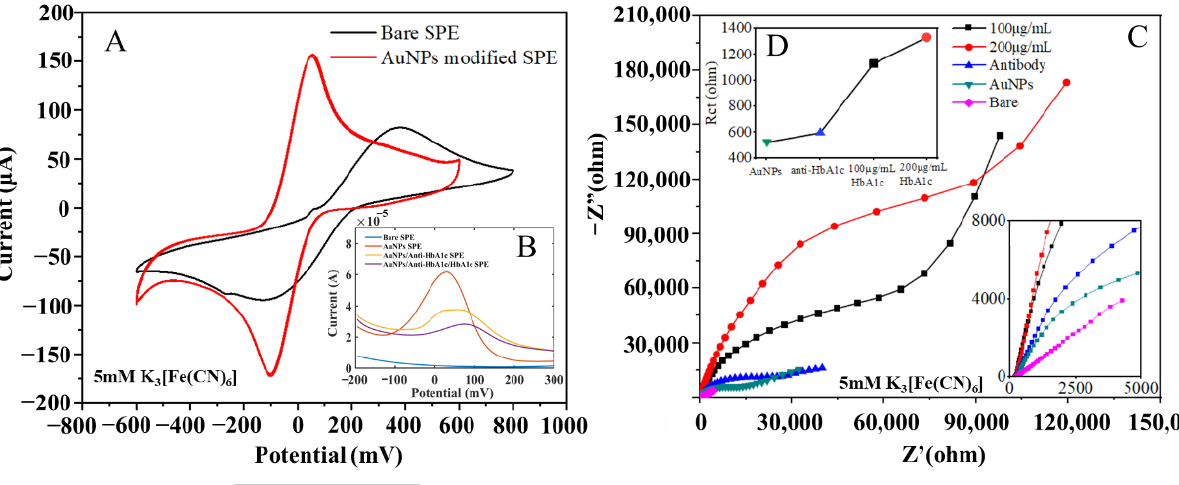
Figure 3. ( A ) CV response of SPEs before and after AuNPs modification. ( B ) DPV response of bare SPE, AuNPs SPE, AuNPs/anti-HbA1c SPE and AuNPs/anti-HbA1c/HbA1c SPE. ( C ) Complex impedance characteristics of electrodes in different states. ( D ) Charge-transfer resistance of electrodes in different